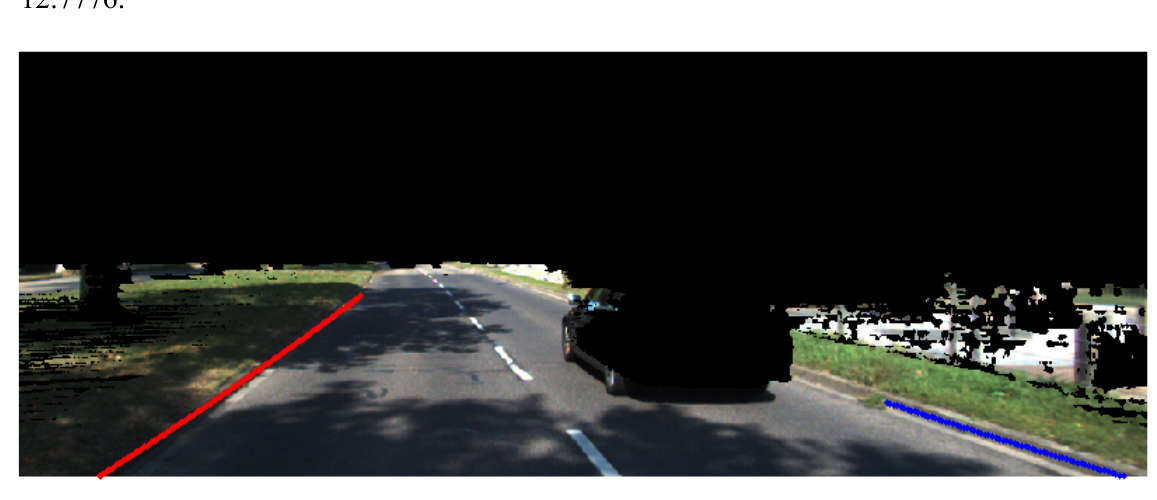
Figure 15. Final results. The confidence score for left curb is 36.6604, and the right is